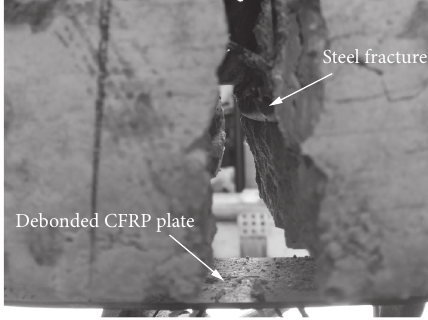
Figure 5: Typical failure of fatigue